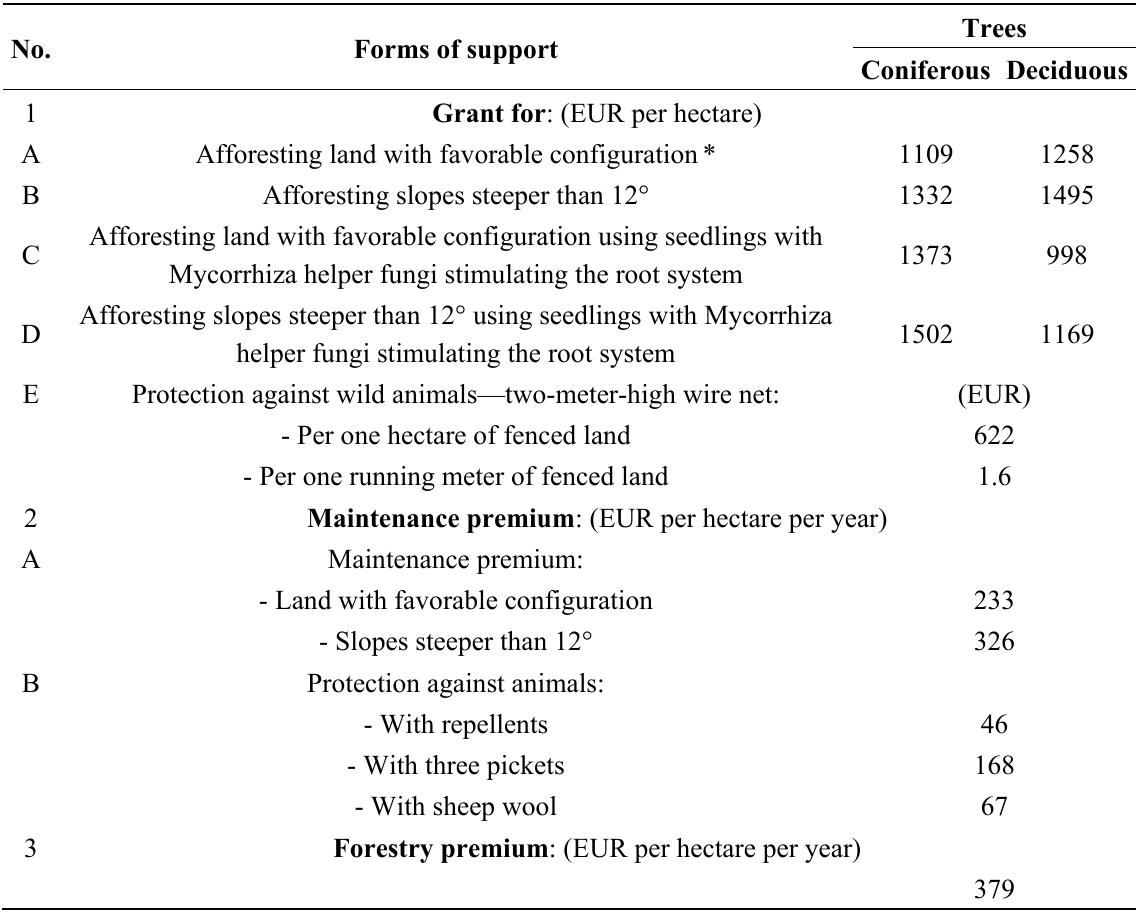
Table 1. Rates of financial support for the afforestation of low-productivity agricultural land, converted to EUR (Average exchange rate: 1 PLN = 0.24 EUR, according to the National Bank of Poland, retrieved on 9 September